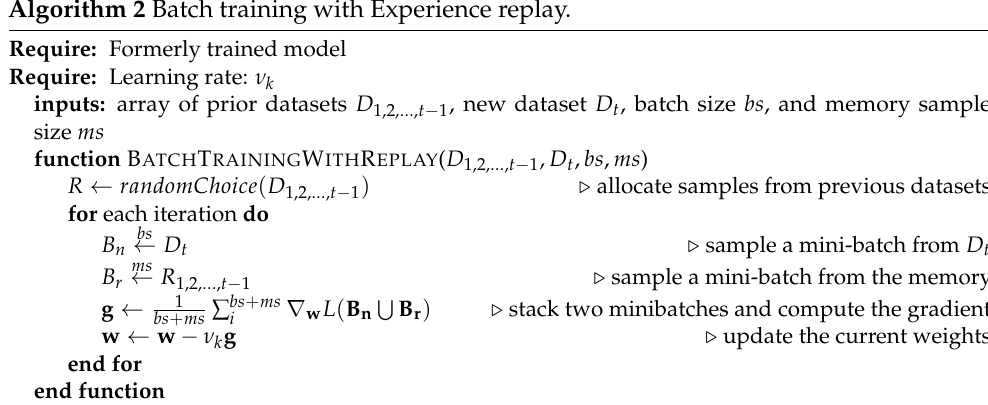
Algorithm 2 Batch training with Experience